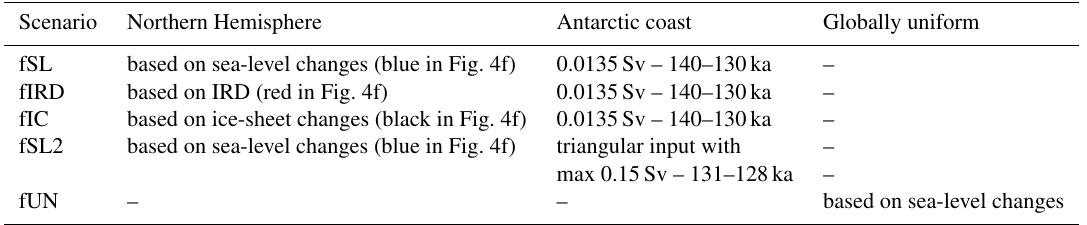
Table 2. Freshwater scenarios for transient simulations of the PDG. Freshwater can be added in the NH and close to the Antarctic coast based on meltwater routing or as a globally uniform flux. The Antarctic freshwater forcing in fSL2 is based on Goelzer et al. (2016a) but scaled down to obtain a total Antarctic contribution of